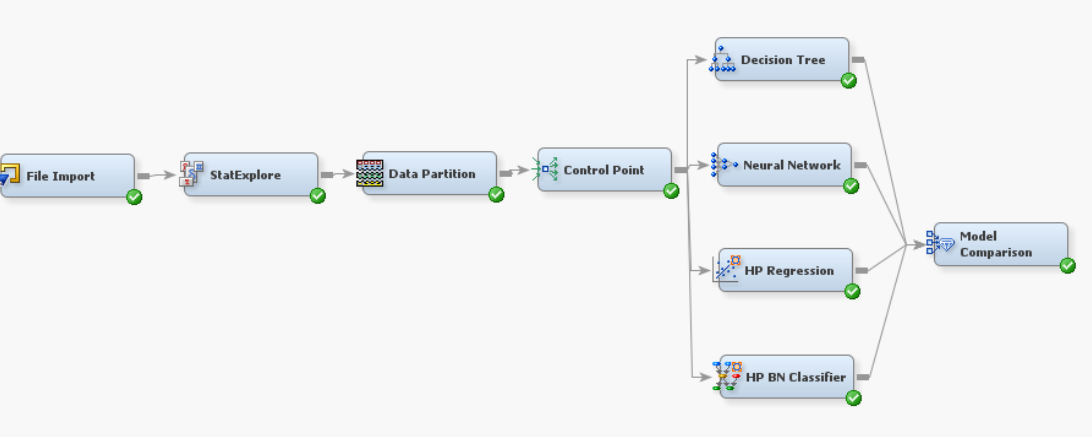
Figure 5. SAS Enterprise Miner interface demonstration.